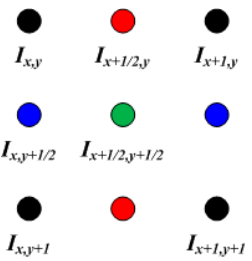
Figure 4. Pixel arrangement in bilinear interpolation algorithm when an input image resolution is doubled.